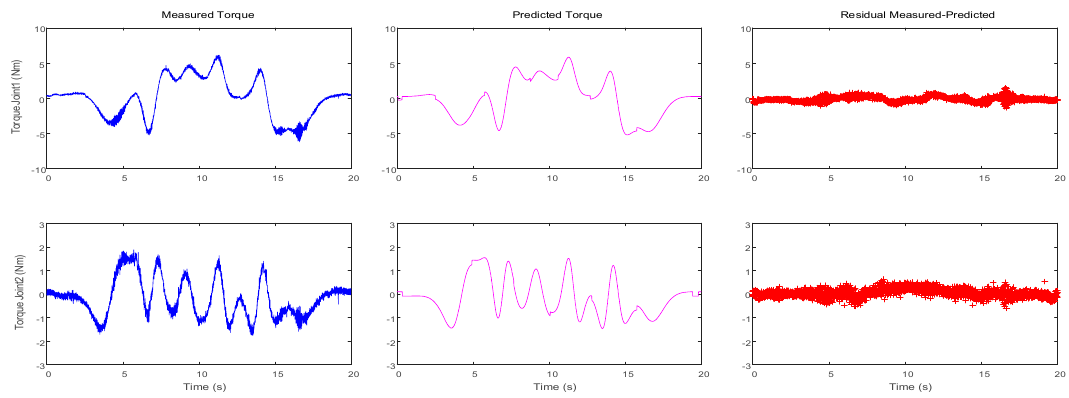
Figure 7. Measured, predicted, and residual torques for the two joints. Sensors 2019 , 19 , x14 14 of 17